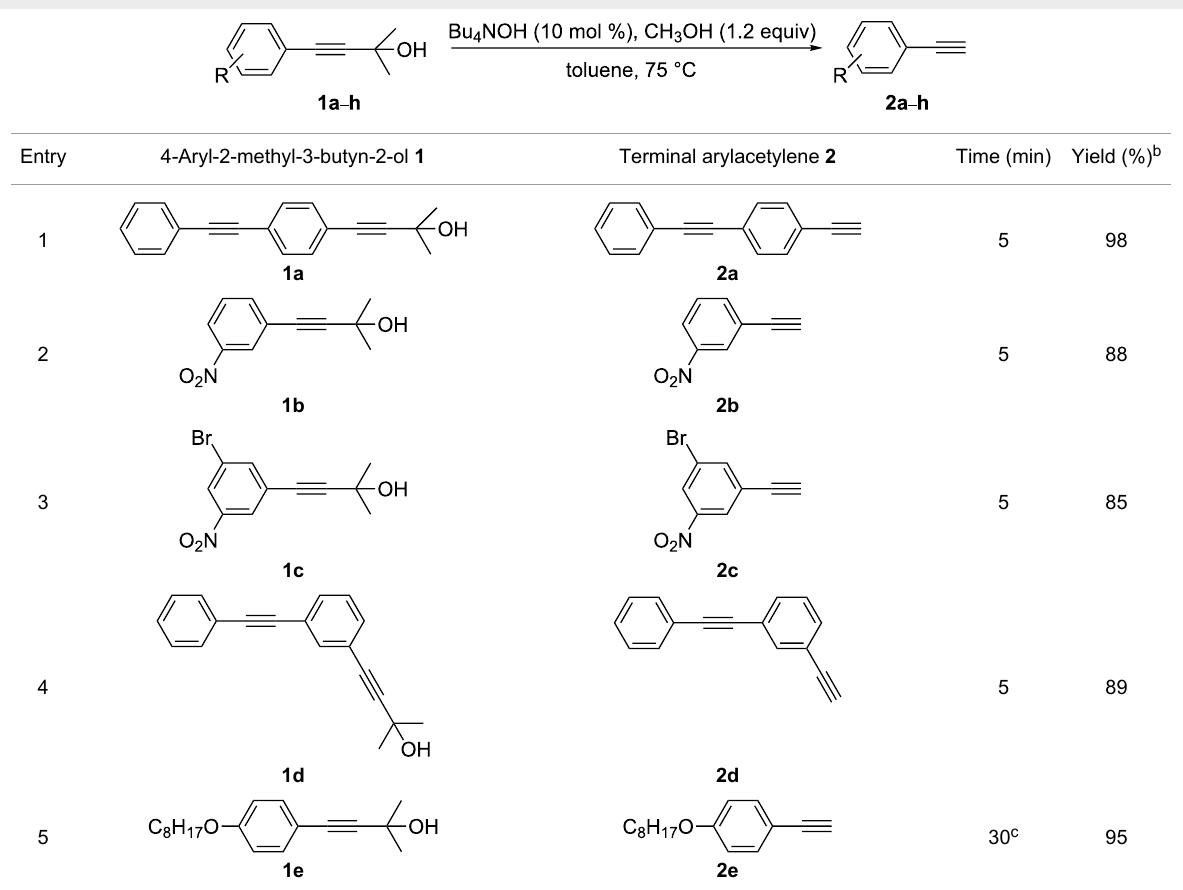
Table 3: Synthesis of different terminal arylacetylenes by removal of 2-hydroxypropyl groups under optimal conditions a